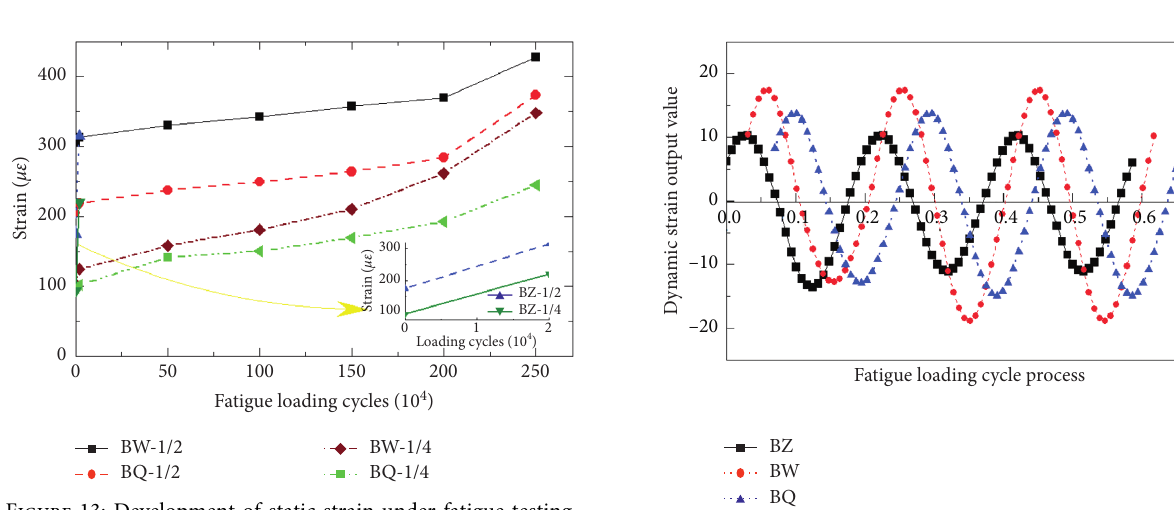
Figure 15: Dynamic strain of test plate under fatigue testing.